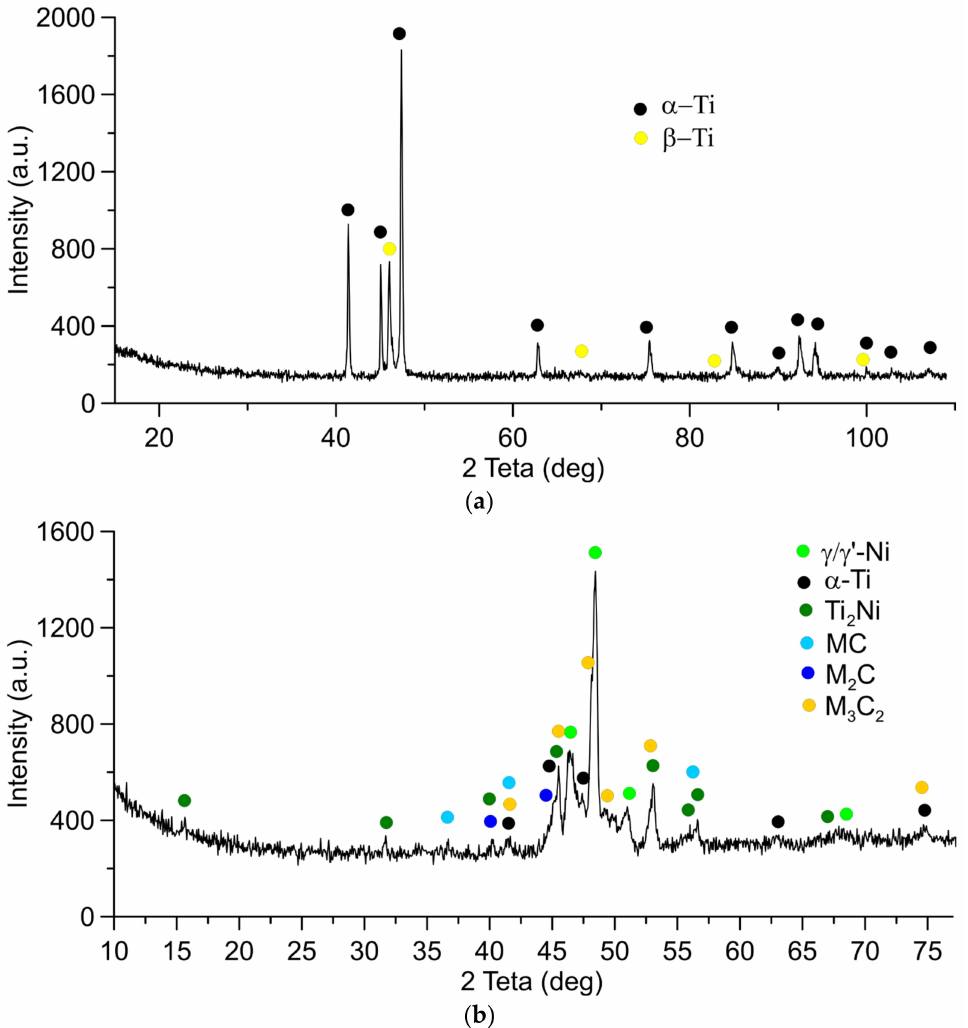
Figure 5. The X-ray diffraction patterns from the stir zone on the welded titanium alloy ( a ) and tribological layer on the corresponding FSW tool shoulder surface ( b